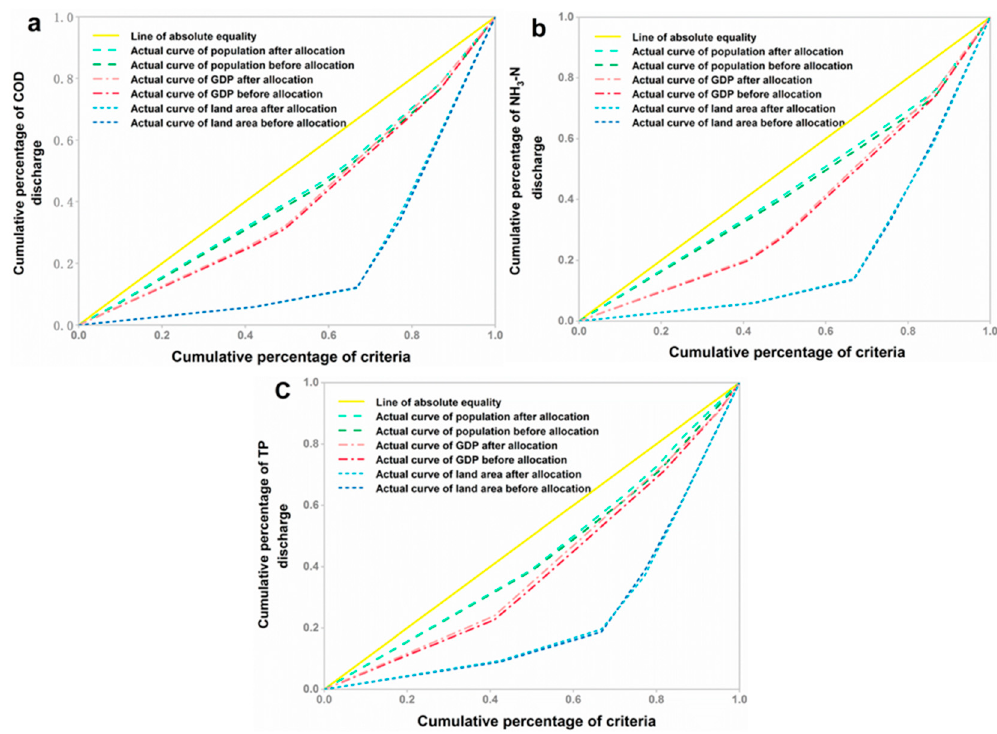
Figure 7. Lorenz curves of pollutant discharge based on the three criteria before and after allocation: ( a ) COD; ( b ) NH 3 -N; and ( c ) TP.